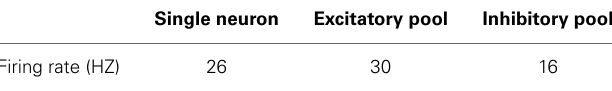
Table 2 | Firing rates of a neuron in single neuron and pools.